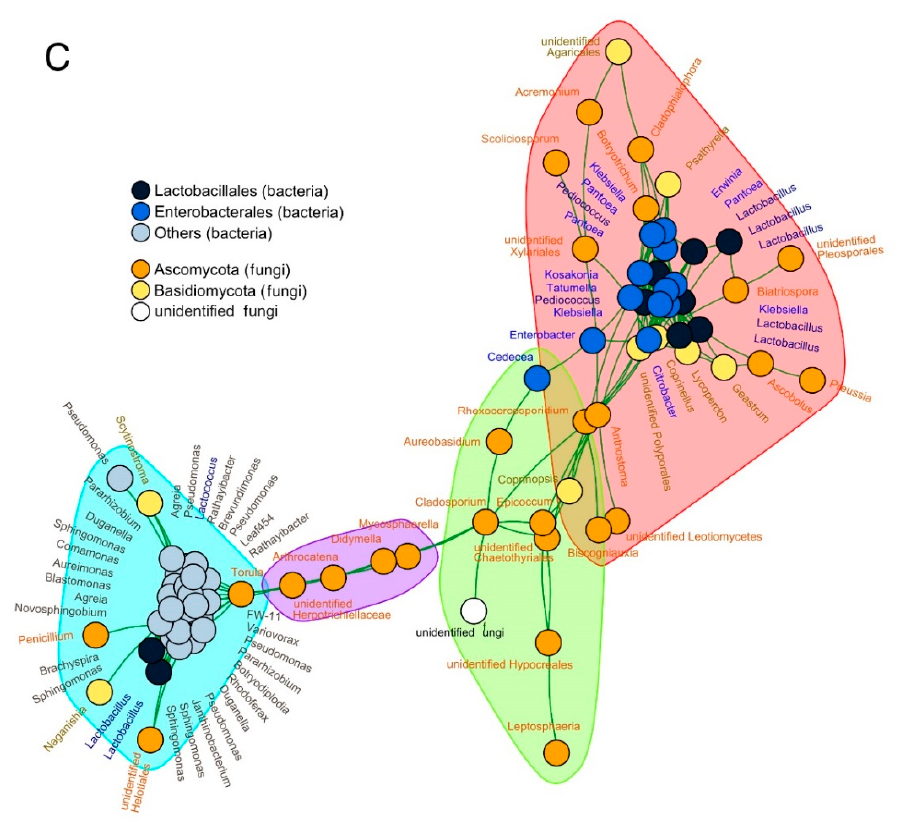
Figure 8. SparCC network analysis of the co-occurring bacterial species and fungal genera in fer- mented preparations of Achillea ( A ), Taraxacum ( B ), and Mercurialis ( C ). Shown are positive correlations between bacterial and fungal taxa. Clusters were calculated by using edge-betweenness between vertices of undirected and unweighted networks. Different colors denote different clusters.